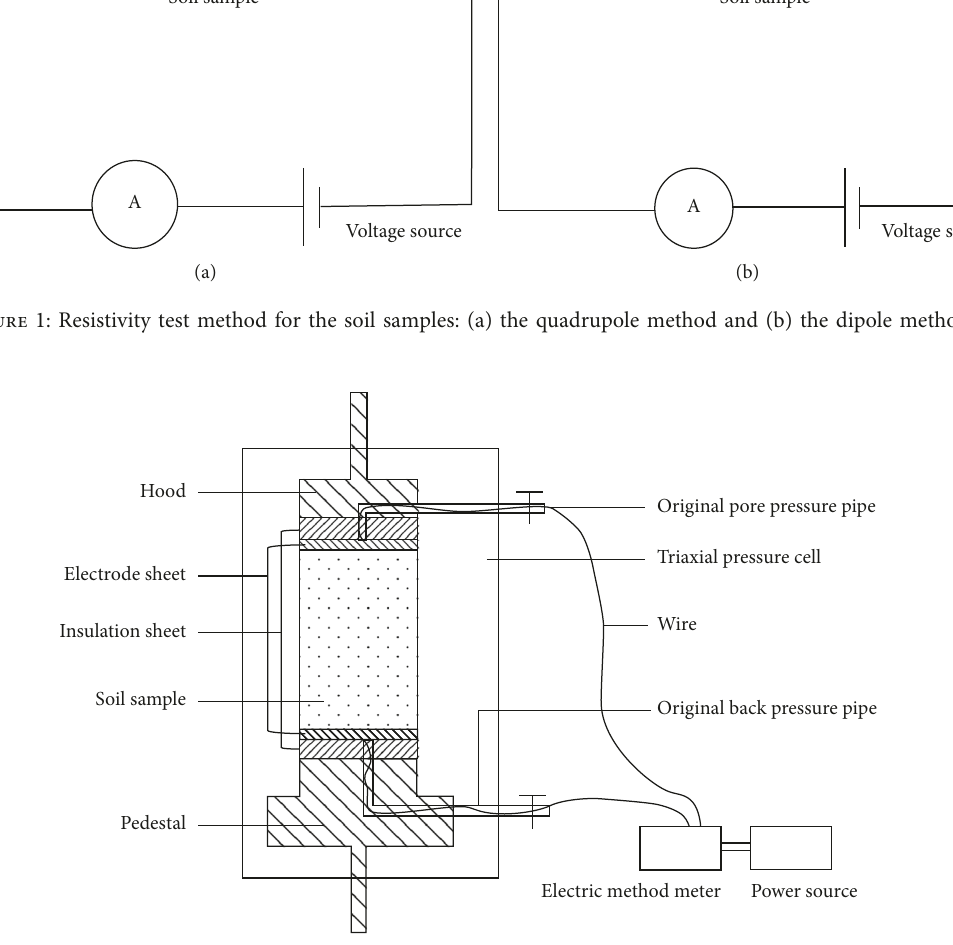
Figure 2: Schematic diagram of the soil sample resistivity test on the dynamic triaxial apparatus.